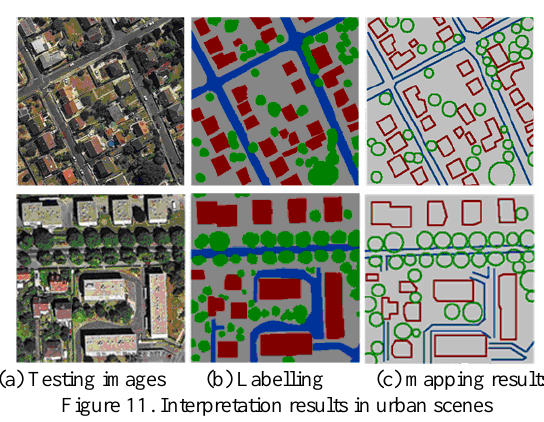
Figure 11. Interpretation results in urban